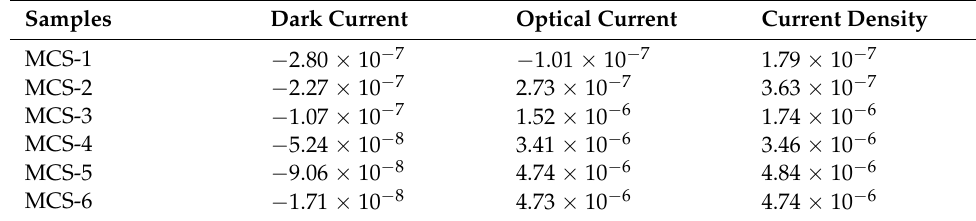
Table 5. The approximate change rate of current